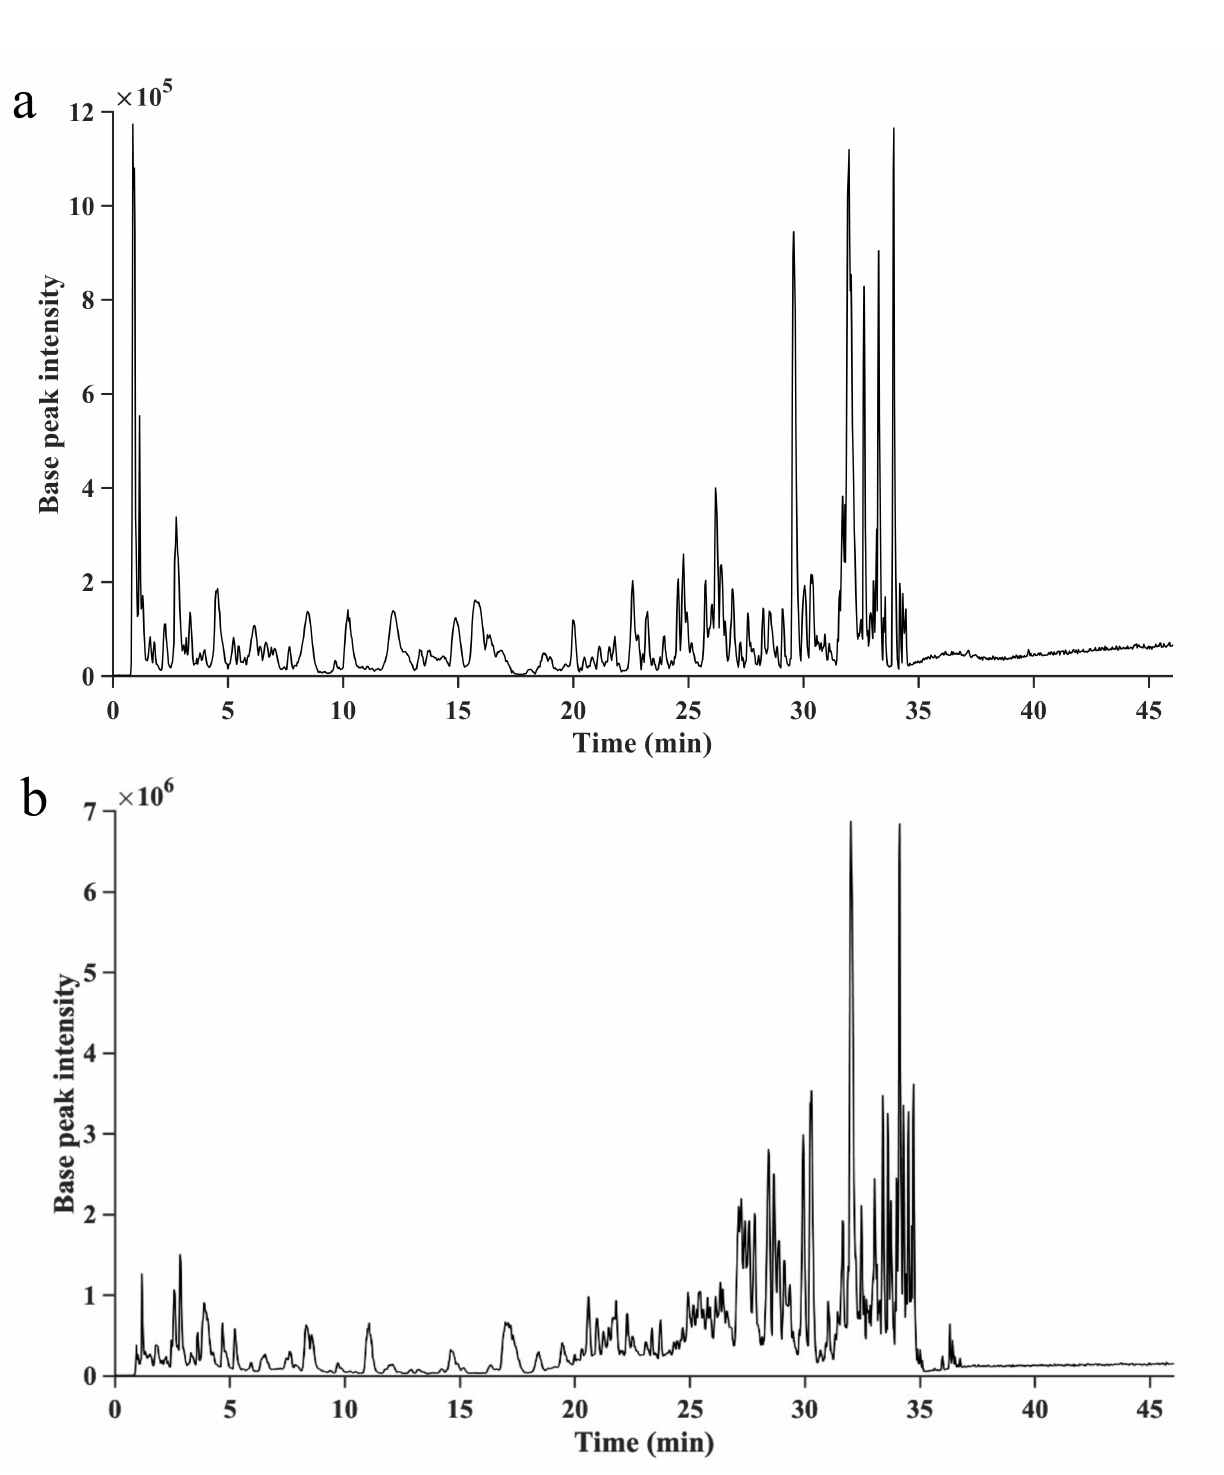
Figure 3. Full scan base peak ion-chromatograms of A. nodosum ( a ) and S. latissima ( b ) extracted with aqueous ethanol (80%, v / v